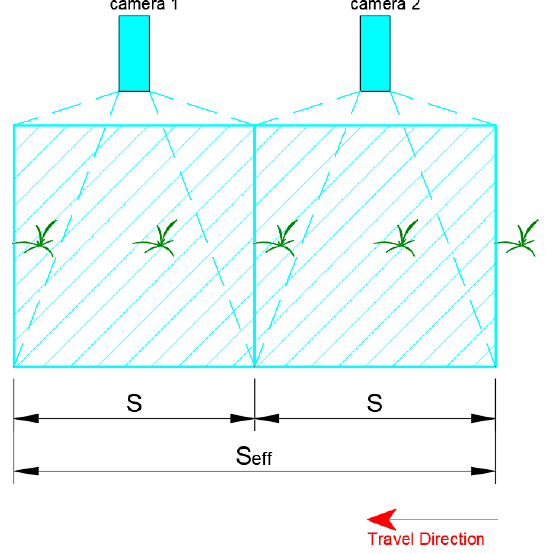
Figure 3. Multiple adjacent cameras for plant detection at n vis = 2. Thus, S ef f = 2 S .